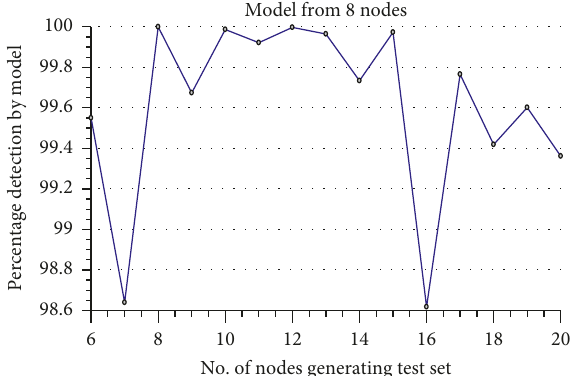
Figure 11: Simulation results for 8 nodes.